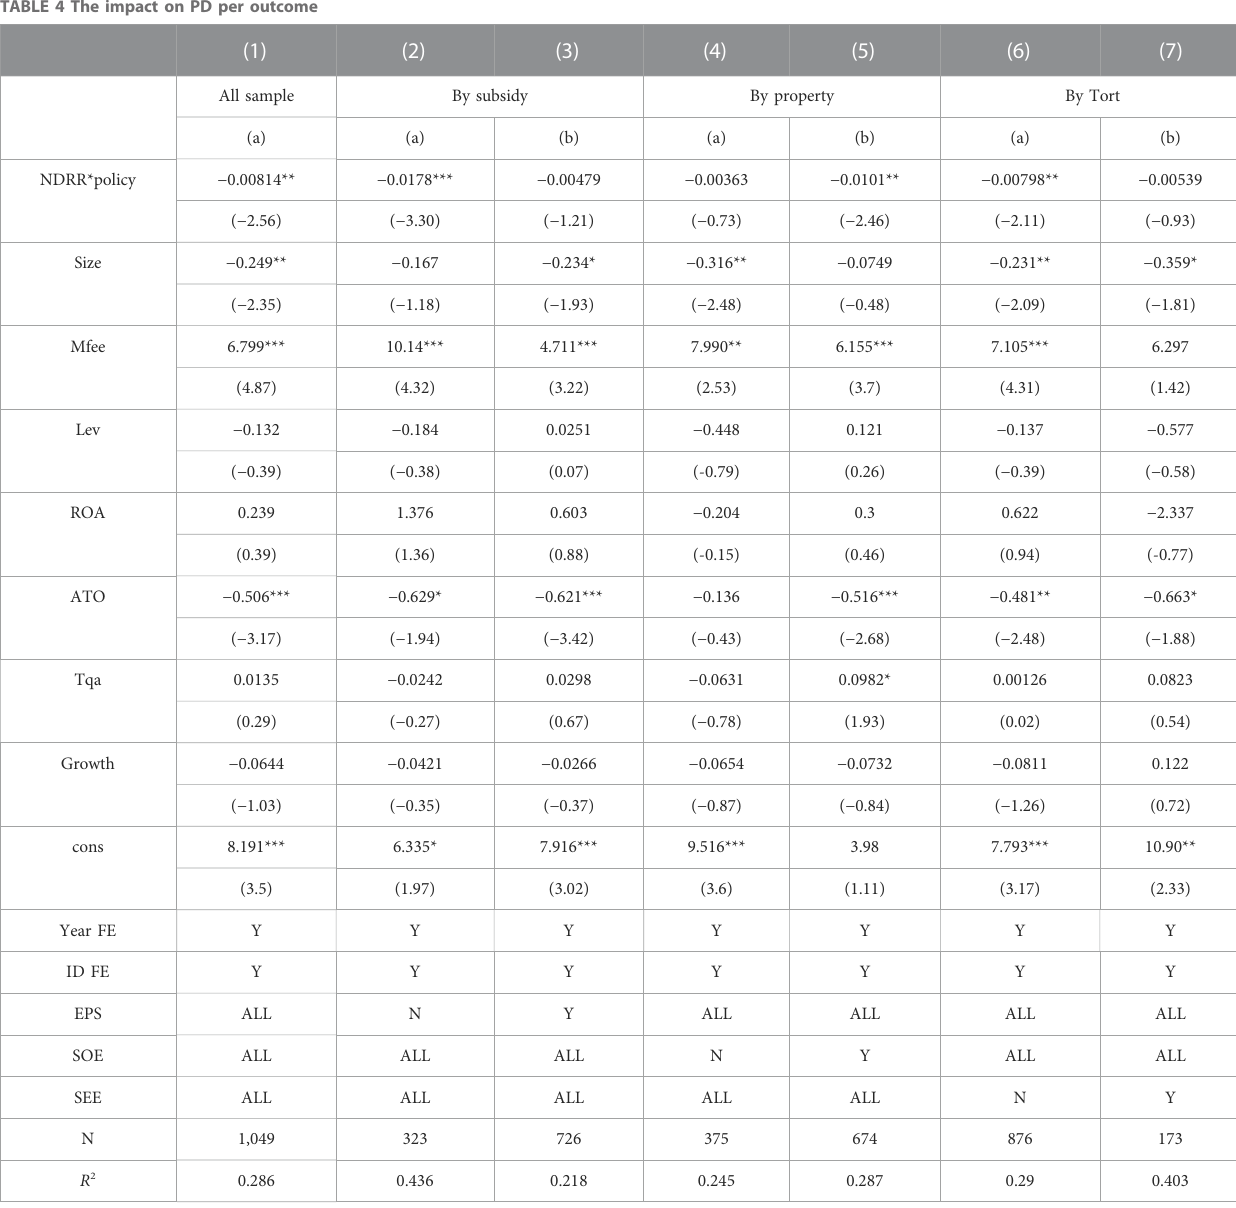
TABLE 4 The impact on PD per